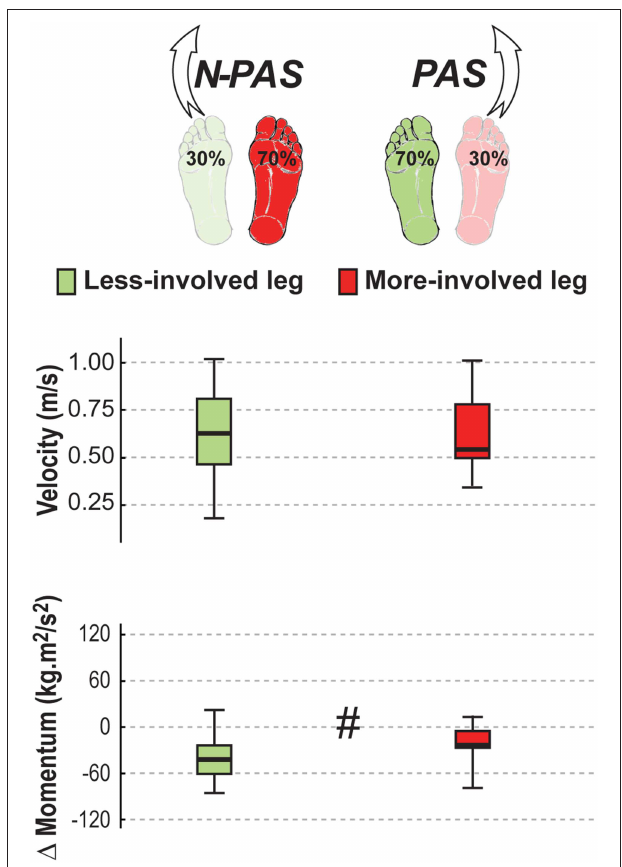
FIGURE 9 | Landing characteristics in stroke. The median (thick line) of the landing variables is presented for the stroke participants when stepping with the less-involved leg in the non-preferred stance condition (N-PAS) and with the more-involved leg in the preferred stance condition (PAS). Boxes represent 25 and 75th percentile. Bars represent min and max values. # Indicates a difference between leg at p <